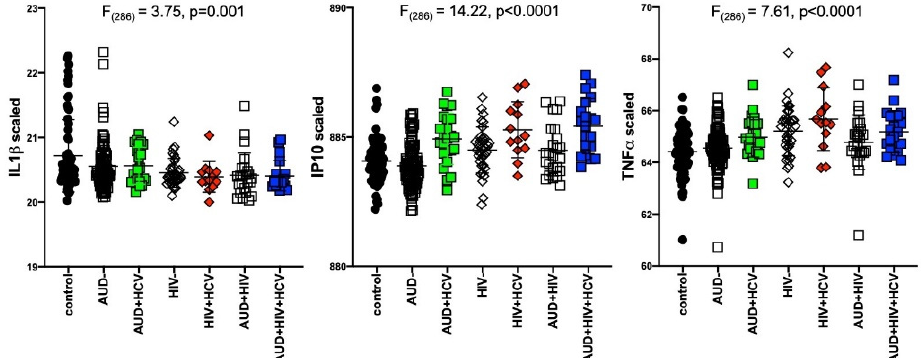
Figure 2. Levels of soluble proteins by hepatitis C virus (HCV) serostatus among patient groups. IL1 β : relative to controls, lower in AUD ( p = 0.008), HIV ( p = 0.001), HIV+HCV ( p = 0.007), AUD+HIV ( p = 0.001), AUD+HIV+HCV ( p = 0.002). IP10: relative to controls, higher in AUD+HCV ( p < 0.0001), HIV ( p = 0.02), HIV+HCV ( p < 0.0001), AUD+HIV ( p = 0.5), AUD+HIV+HCV ( p < 0.0001). Higher in AUD+HCV vs. AUD ( p < 0.0001), HIV+HCV vs. HIV ( p = 0.009), AUD+HIV+HCV vs. AUD+HIV ( p = 0.0008). black circles: healthy controls; open squares: AUD; filled squares: AUD+HCV; open triangles: HIV; filled triangles: HIV+HCV; open diamonds: AUD+HIV; filled diamonds: AUD+HIV+HCV.